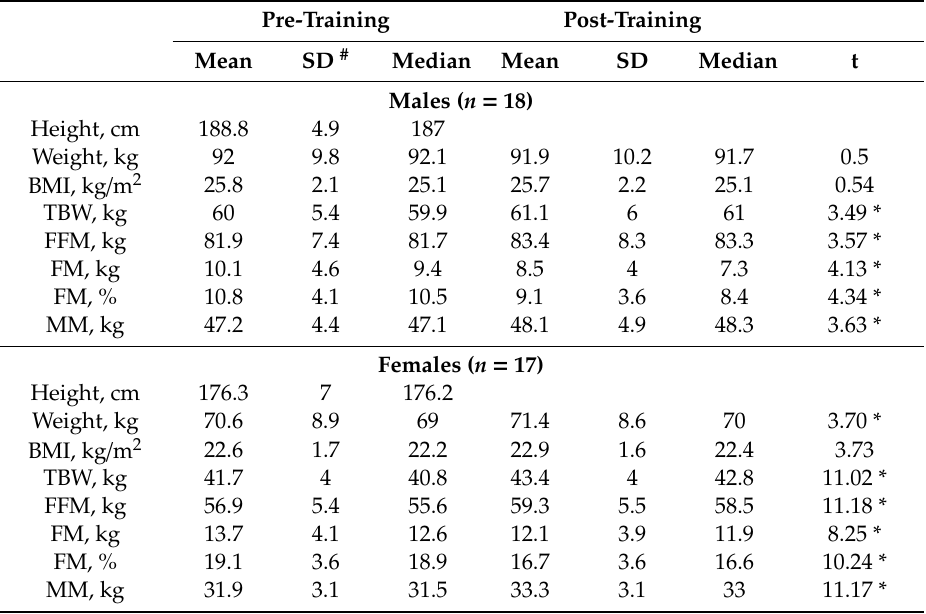
Table 2. Descriptive statistics (means [M], standard deviations [SD], and medians [Md]) for body mass and estimates of body composition among male and female handball players before and after training, and results of t-tests comparing pre- and post-training measures.